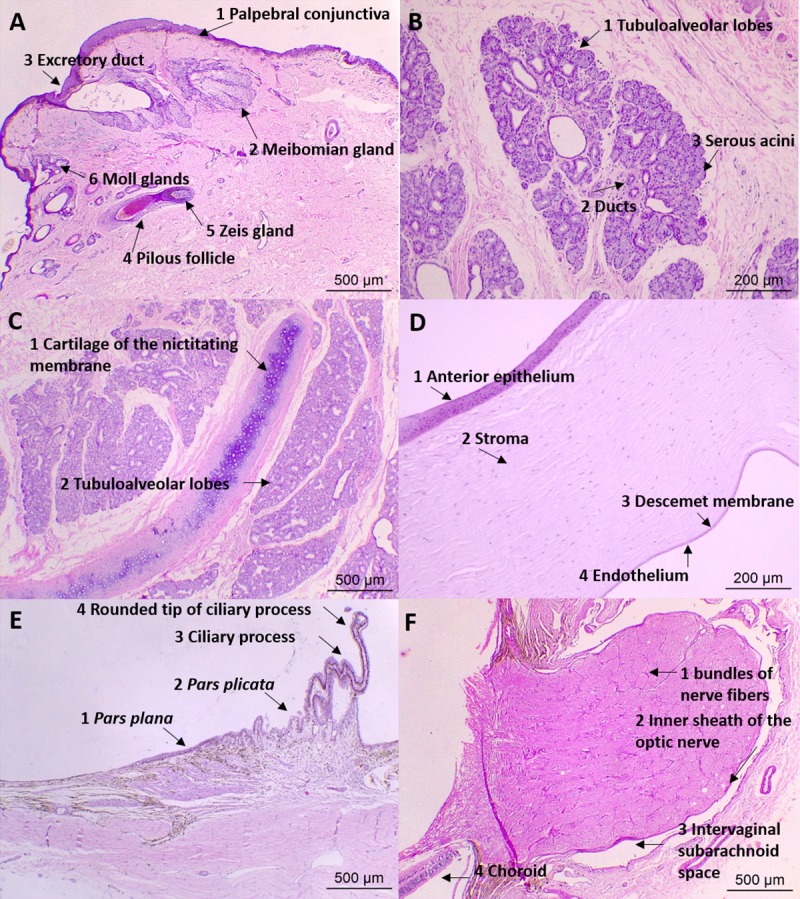
Photomicrography of the eye and adnexa of crab-eating fox.(A) Lower eyelid: 1, palpebral conjunctiva; 2, meibomian gland, with the presence of 3, excretory duct; 4, pilous follicle in close association with 5, the Zeis gland at its base, and 6, Moll glands; HE, 5X magnification. (B) Tubuloalveolar lacrimal gland formed by: 1, lobes and lobules; 2, ducts; 3, serous acini; HE, 10X magnification. (C) Nictitating membrane gland: 1, cartilage of the nictitating membrane; 2, tubuloalveolar lobes and lobules; HE, 5X magnification. (D) Cornea and its layers: 1, anterior epithelium; 2, stroma; 3, Descemet membrane; 4, endothelium; HE, 10X magnification. (E) Ciliary body: 1, pars plana; 2, pars plicata; 3, ciliary process, with the outer pigmented layer and inner nonpigmented layer, 4, rounded tip and presence of blood vessels; HE, 5X magnification. (F) Optic nerve head and optic nerve: 1, bundles of nerve fibers; 2, inner sheath of the optic nerve; 3, intervaginal subarachnoid space; 4, choroid; HE, 5X magnification.